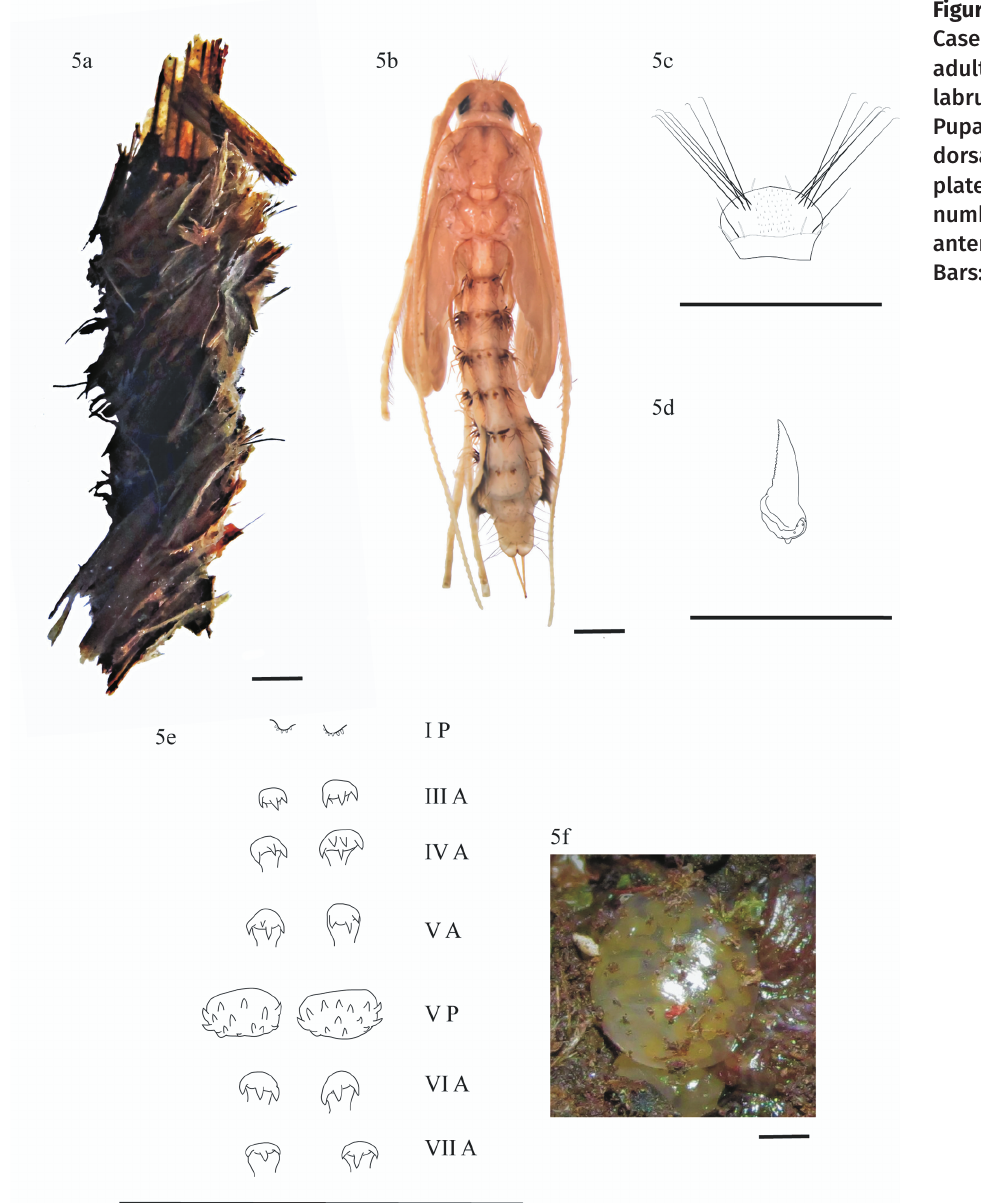
Figure 5. Verger lutzi . (a) Case, lateral. (b) Farate adult, dorsal. (c) Pupal labrum, dorsal. (d) Pupal right mandible, dorsal. (e) Pupal dorsal plates. (f) Eggs. I-VII: number of segment. A: anterior. P: posterior. Bars: 2